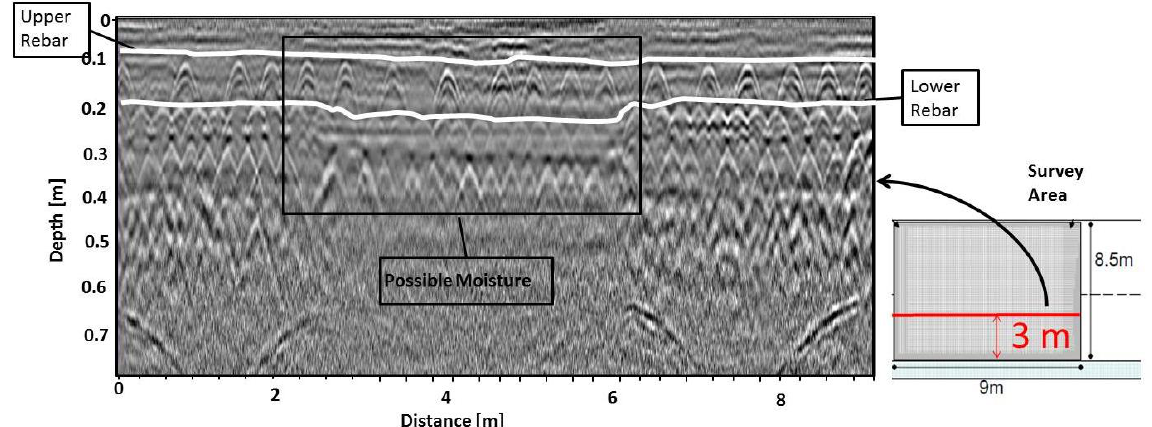
Figure 11. 2 GHz antenna processed data and possible explanations (interpretation by author)